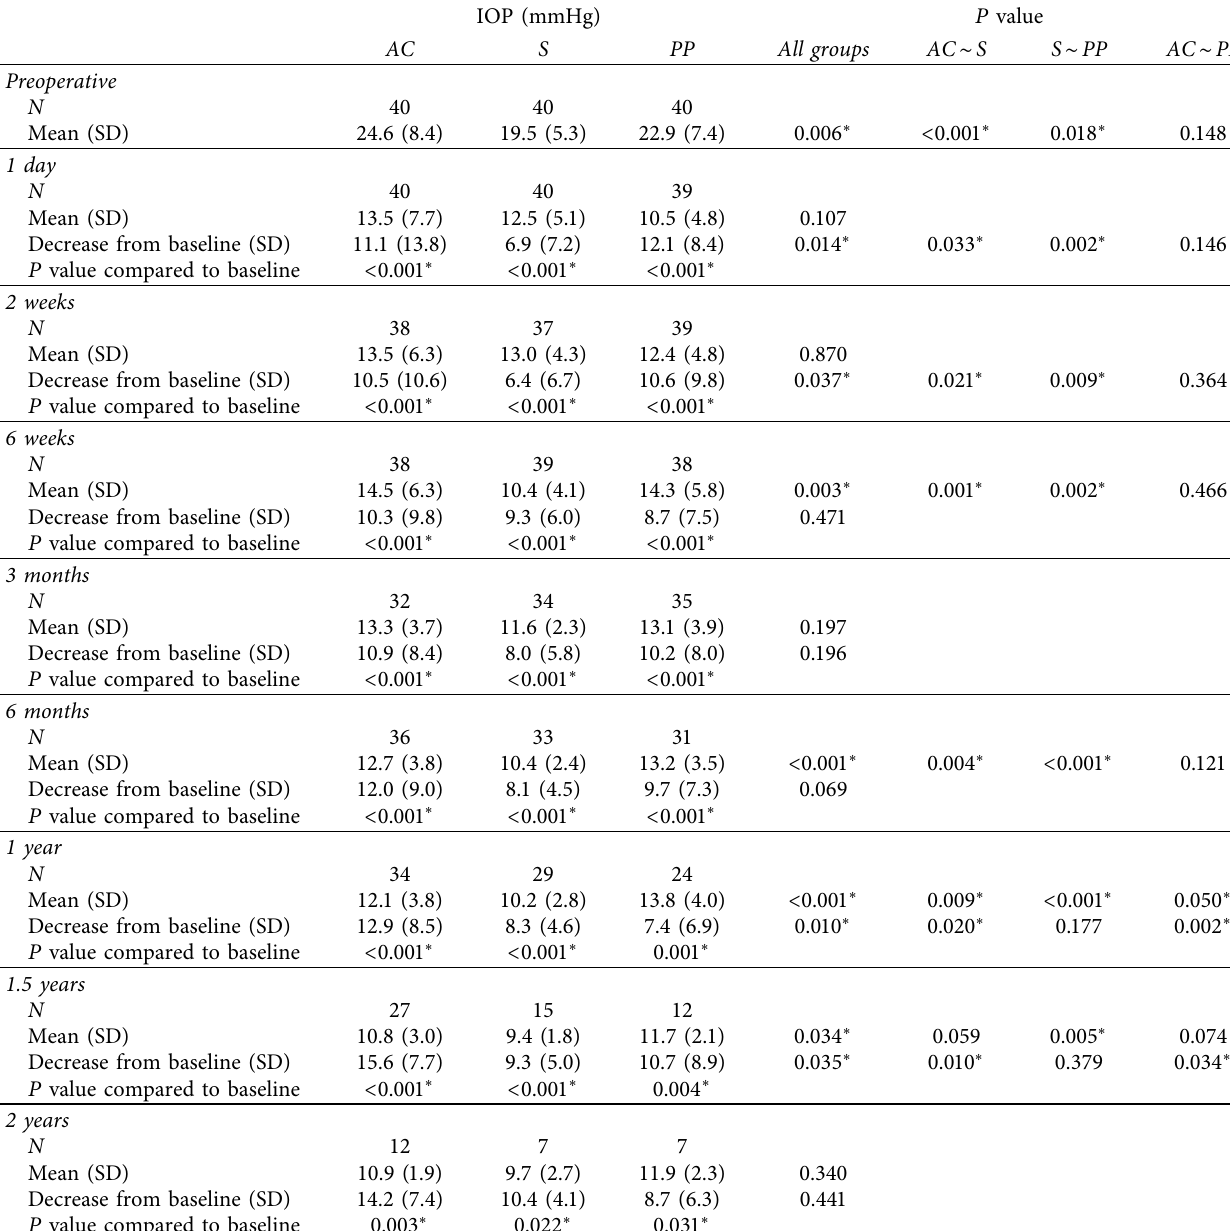
Table 3: IOP outcomes data a